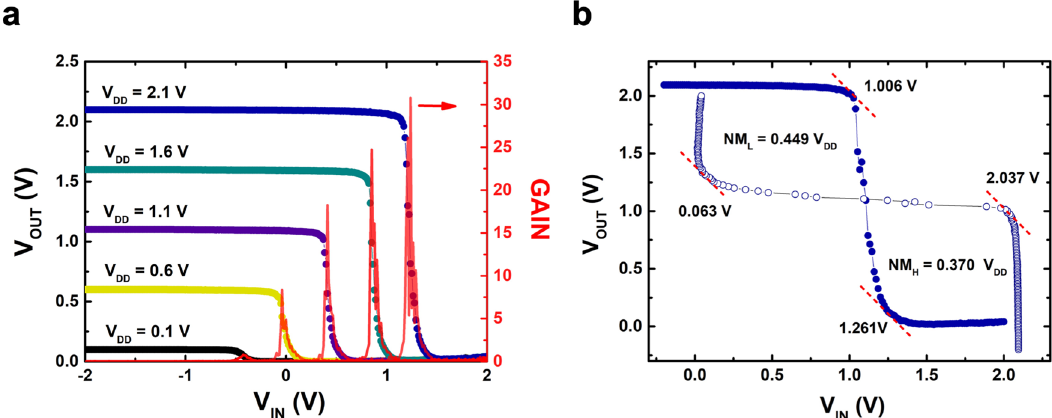
Fig. 5 Output characteristics of 3D Si-MoS 2 complementary inverter. a Voltage transfer characteristics of the 3D CMOS inverter for power supply voltage ( V DD ) from 0.1 V to 2.1 V in 0.5 V steps. Peaks in the red curves indicate the corresponding voltage gain at different V DD . b Noise margin of a CMOS inverter. When the inverter was applied with a low input voltage, the noise margin low ( NM L ) is 0.449 V DD ( V DD = 2.1 V). When applied with a high input voltage, the inverter has a noise margin high ( NM H ) of 0.370 V DD ( V DD = 2.1 V).